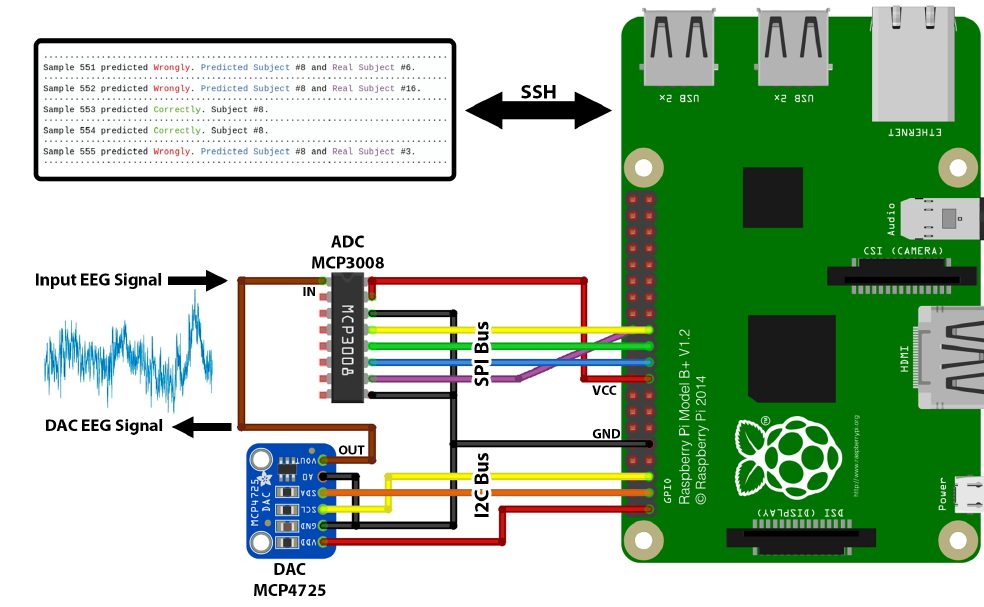
Figure 7. System hardware setup.